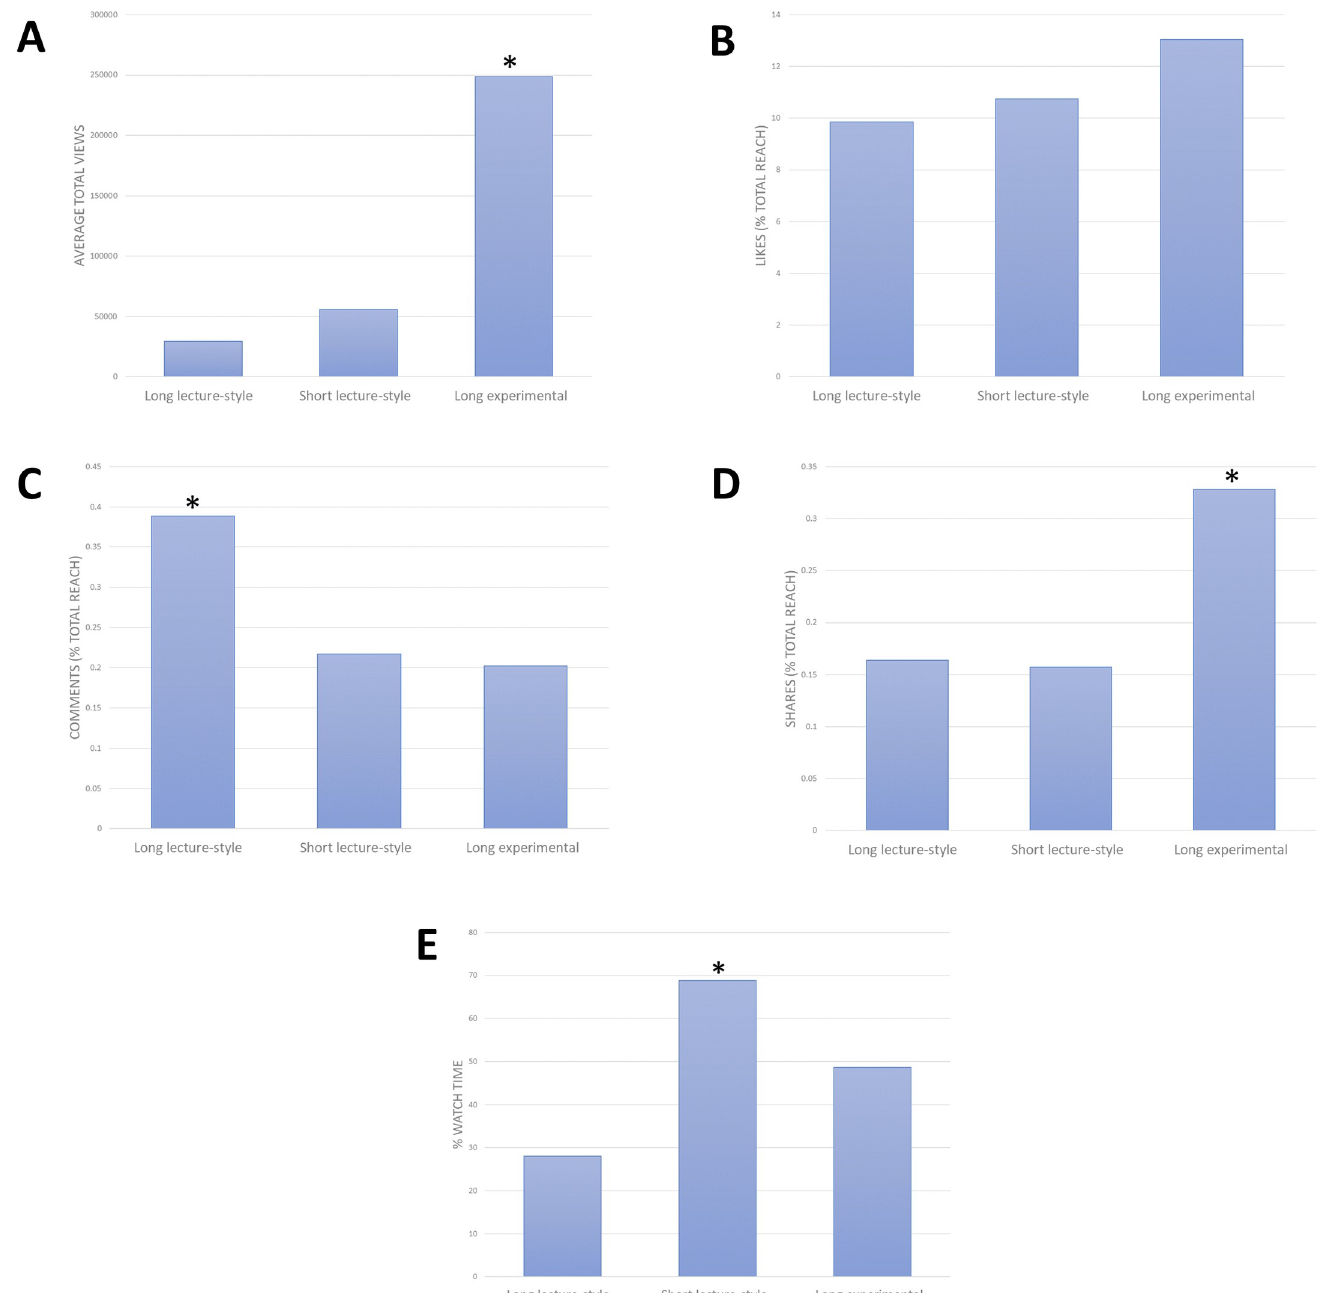
Fig 1. Analytical metric data obtained for three types of ESC videos posted to TikTok platform. The three categories of ESC are long-lecture style videos (40–60 seconds in length), short lecture style videos (15 seconds in length), and long experimental-style videos (40–60 seconds in length). � Indicated statistical significance (p < 0.05). A) Average total number of views for the three categories of videos. B) Average number of likes as a percentage of total post reach for the three categories of videos. C) Average number of comments as a percentage of total post reach for the three categories of videos. D) Average number of shares as a percentage of total reach for the three categories of videos. E) Average percentage watch time for each of the three categories of videos.